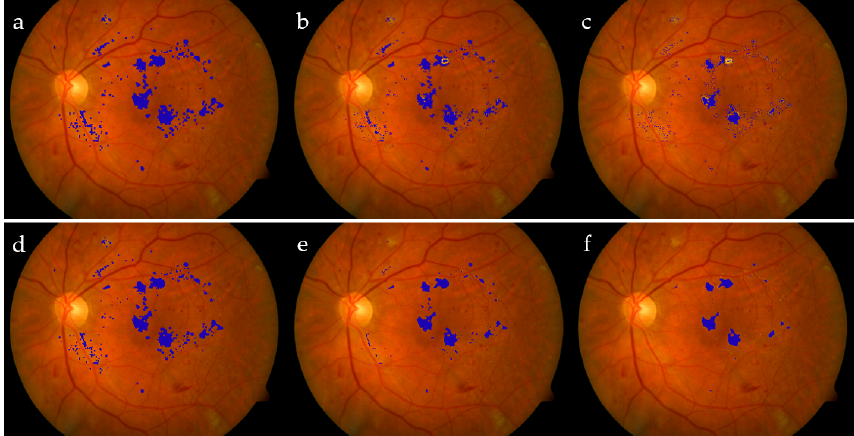
Figure 11. Exudates detected by using the standard deviation of intensity for window sizes: 3 × 3 ( a ), 11 × 11 ( b ), and 17 × 17 ( c ). Exudates detected by using entropy for window sizes: 3 × 3 ( d ), 11 × 11 ( e ), and 17 × 17 ( f ).